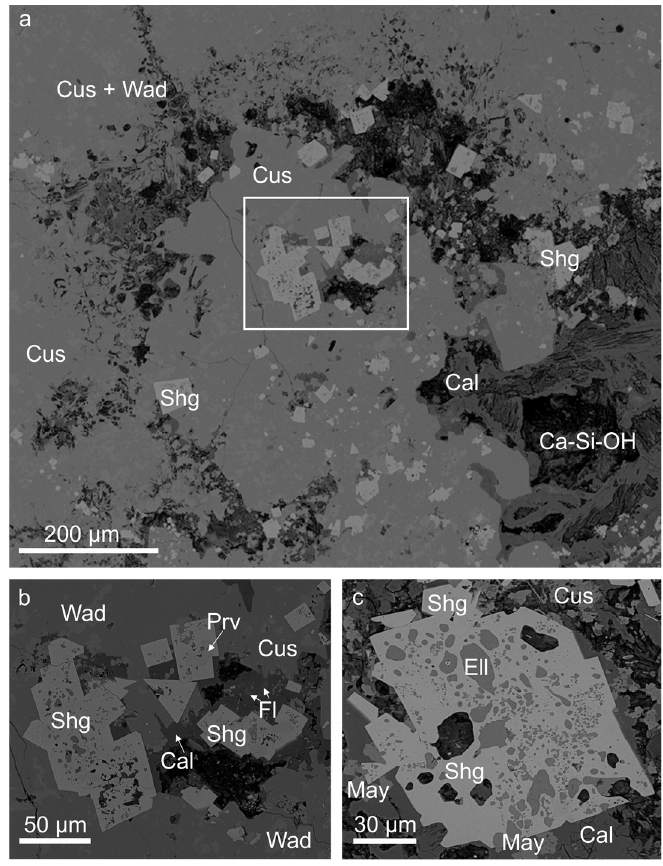
Figure 2. ( a ) General view of a metacarbonate xenolith with sharyginite from the Caspar quarry, Bellerberg volcano; fragment in the frame is magnified in Figure 2b; ( b ) Euhedral crystals and